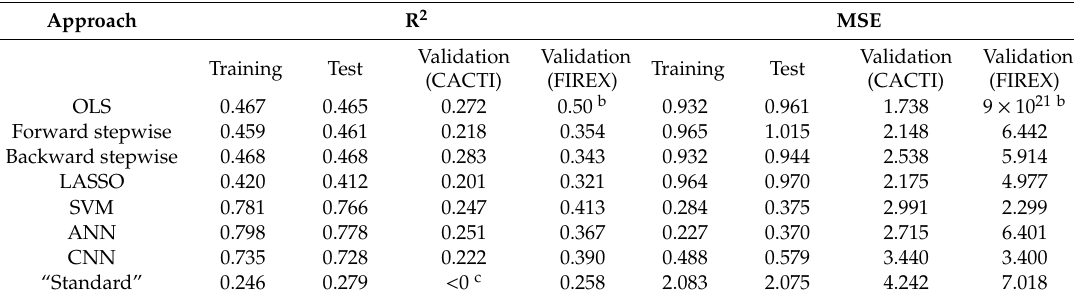
Table 4. The performance of the seven data analytical techniques along with the “standard” assumption of MAC BC a